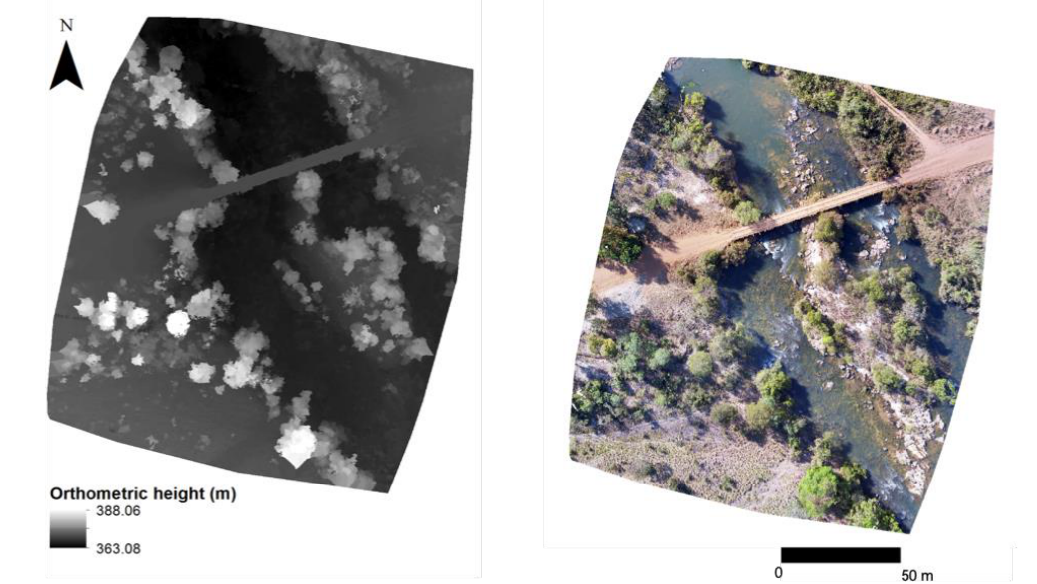
Figure 8. DSM and orthomosaic produced from the densified 3D point cloud (Figure 6c).